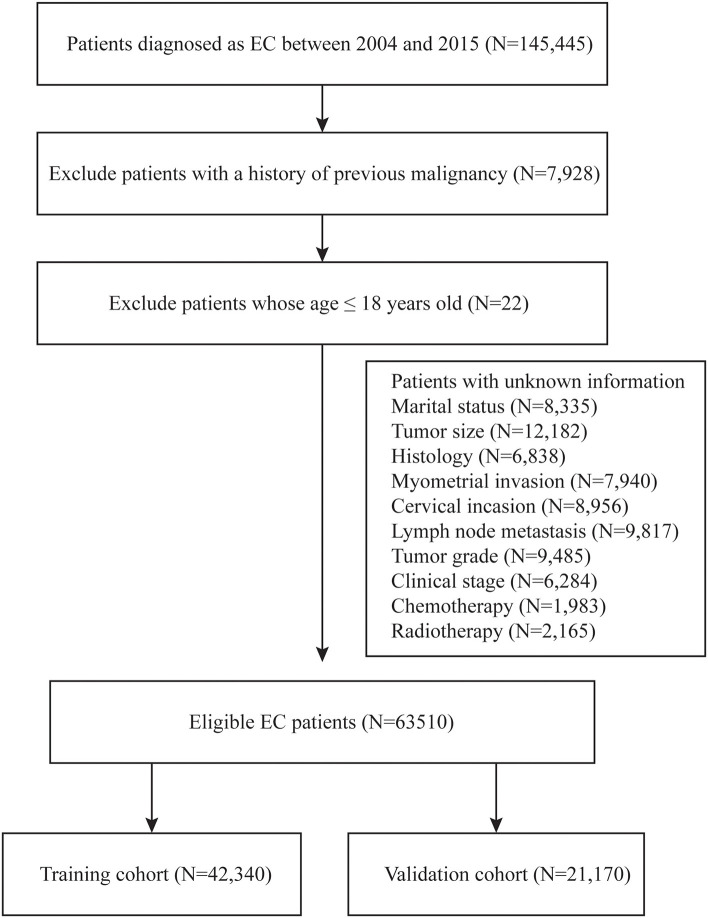
Flow diagram of inclusion criteria and exclusion criteria. According to the criteria, 145,440 patients were collected from the SEER database and randomly assigned into the training cohort (N = 42,340) and validation cohort (N = 21,170).